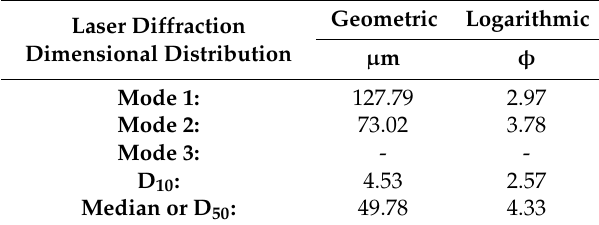
Table 2. Results from laser diffraction.